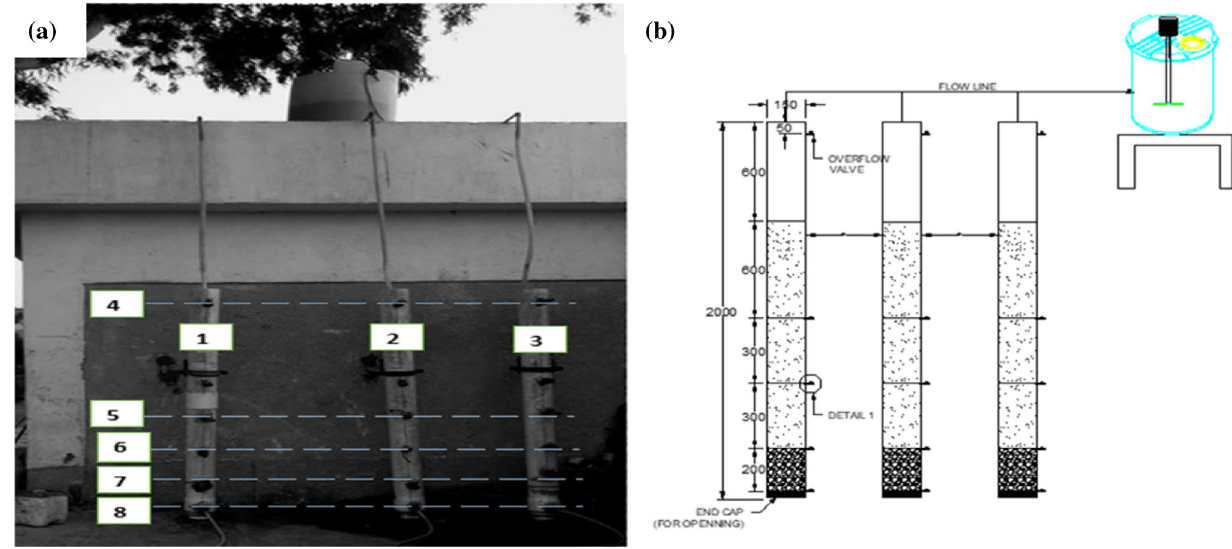
Fig. 1 a The experimental setup of the sand filter, b a schematic diagram for the layout of the experiment